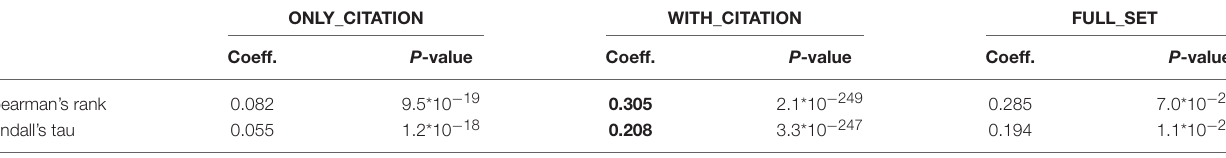
TABLE 2 | Comparing citation contexts.